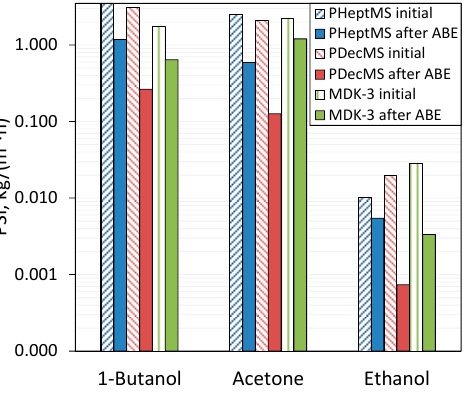
Figure 9. Comparison of PSI at 30 °C of PHeptMS, PDecMS, and MDK-3 membranes before and after membrane contact with ABE-fermentation broth.